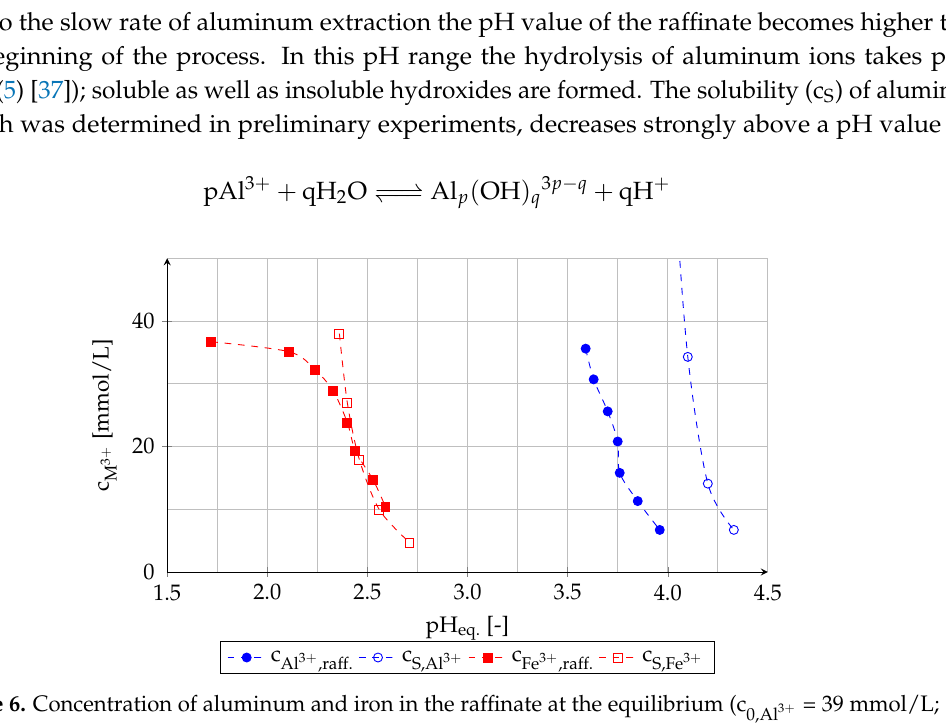
= 39 mmol/L; 0,Al 3 +